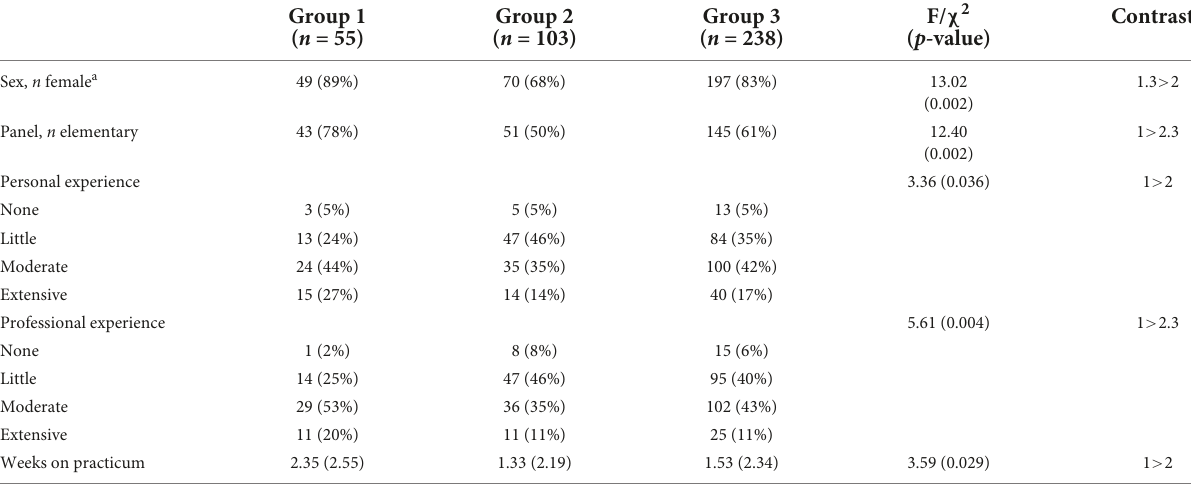
SE,Standarderror. TABLE 3 Characteristics in Year 1 of participants in each trajectory